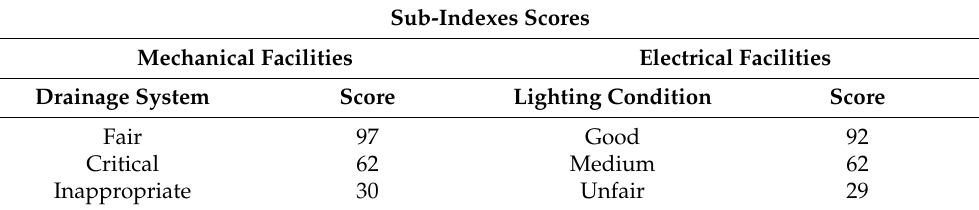
Table 16. Scores of sub-indexes in facilities index.